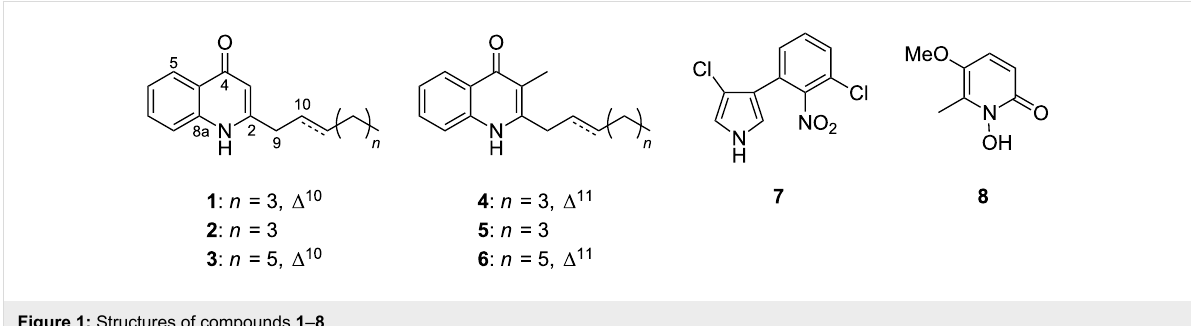
Figure 1: Structures of compounds 1 – 8